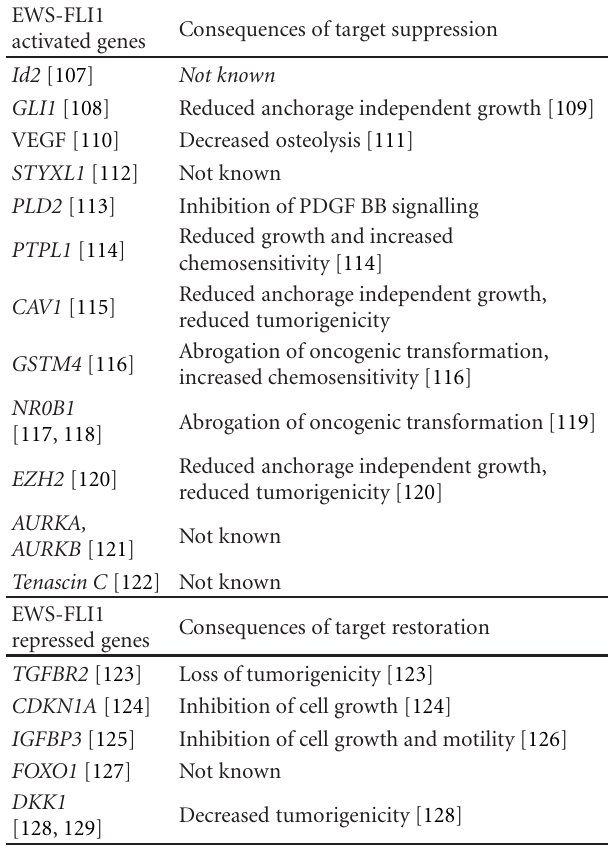
Table 3: Validated direct EWS-FLI1 target